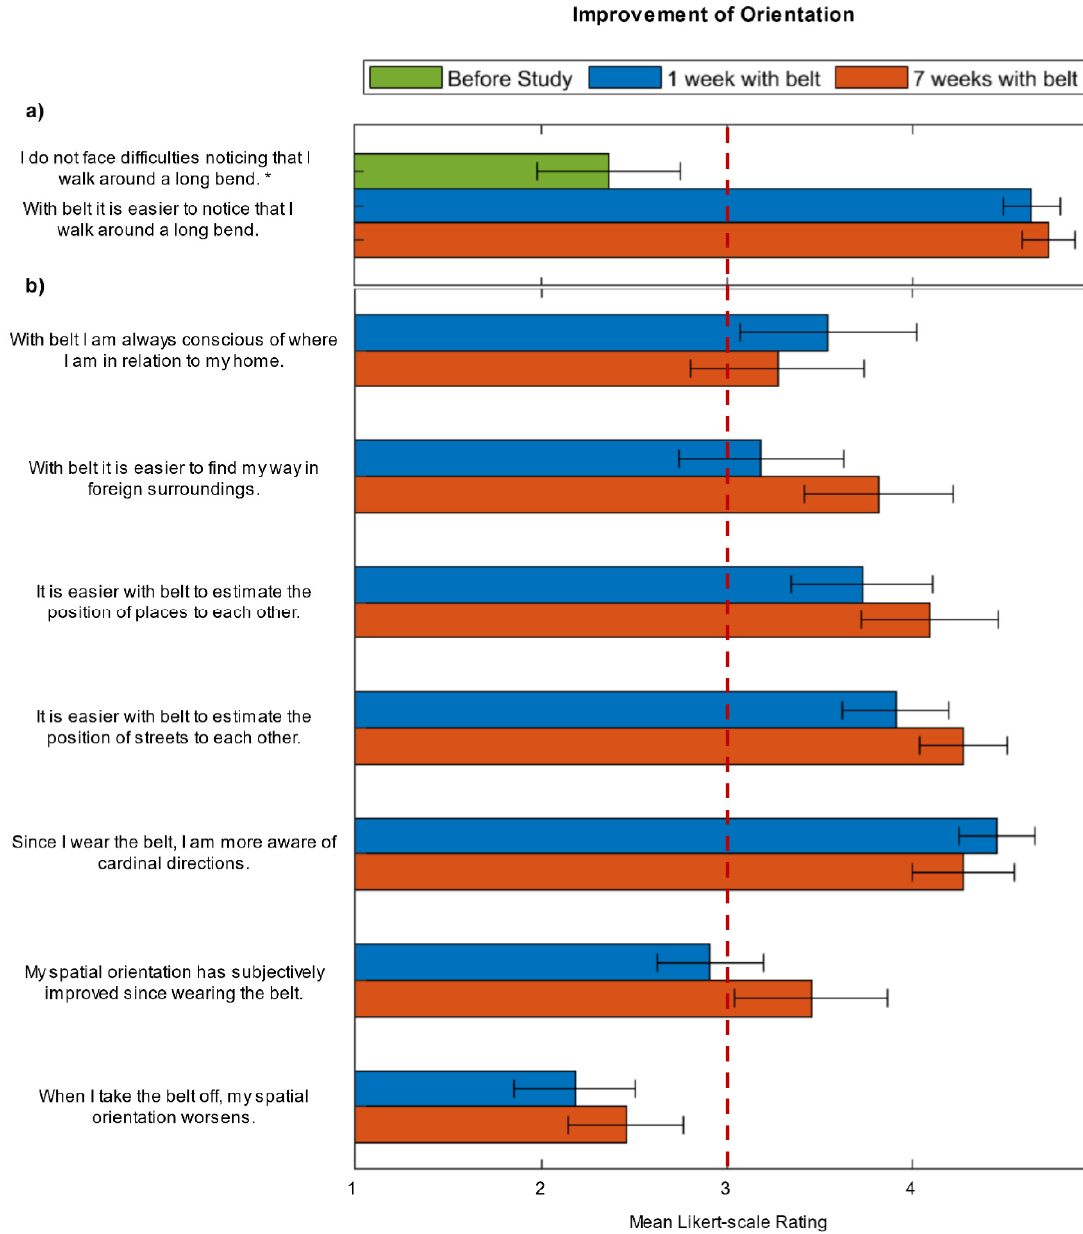
Figure 7. ( a ) The mean Likert scale ratings with the SEM express the participants’ own evaluations of the difficulty to detect a long bend before having been in contact with the belt i.e., before the study (green) and the facilitation experienced in the respective task through the belt after one week with belt (blue) and after seven weeks of wearing the belt (red) i.e., after the study. ( b ) The mean Likert-Scale ratings with the SEM of the self-assessment of improvement in orientation after one week of training (blue), and after seven weeks of training (red) are depicted. * Inverted values of the original question “I face difficulties noticing that I walk around a long bend” are depicted.